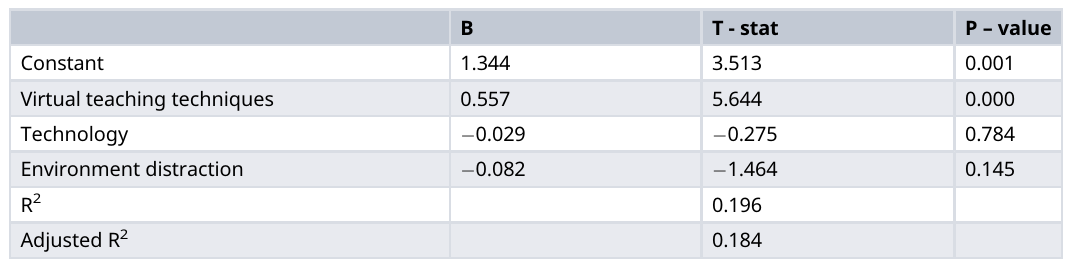
Table 2. Regression